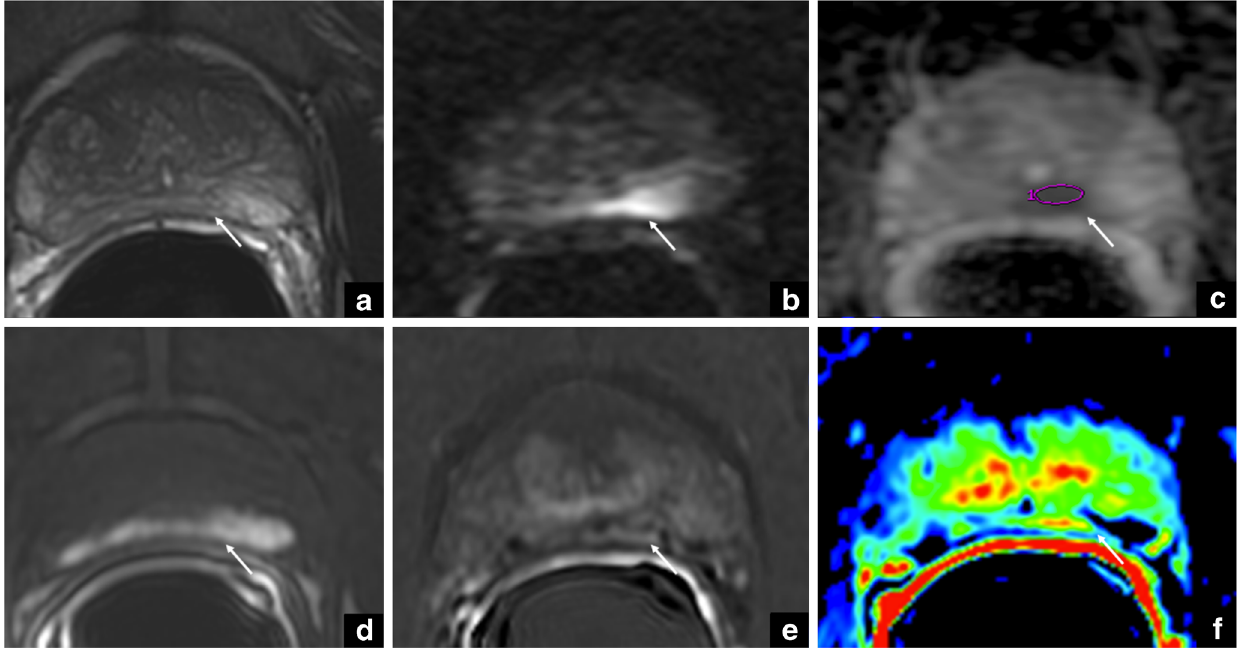
intravenous bolus of gadobutrol (Gadovist, 1 mmol/mL; Bayer Schering Pharma, Berlin, Germany). DWI parameters were: TR ≥ 3000 ms; TE ≤ 90 ms; slice thickness ≤ 4 mm, no gap; field of view:160 – 220 mm; in plane dimension ≤ 2.5 mm phase and frequency; b values for DWI were 0 – 500- and values ranging between 1000 and 3000 s/mm 2 . For ADC maps, if only two b values can be acquired, it is preferred that the lowest b value should be set at 50 – 100 s/mm 2 and the highest should be 800 – 1000 s/mm 2